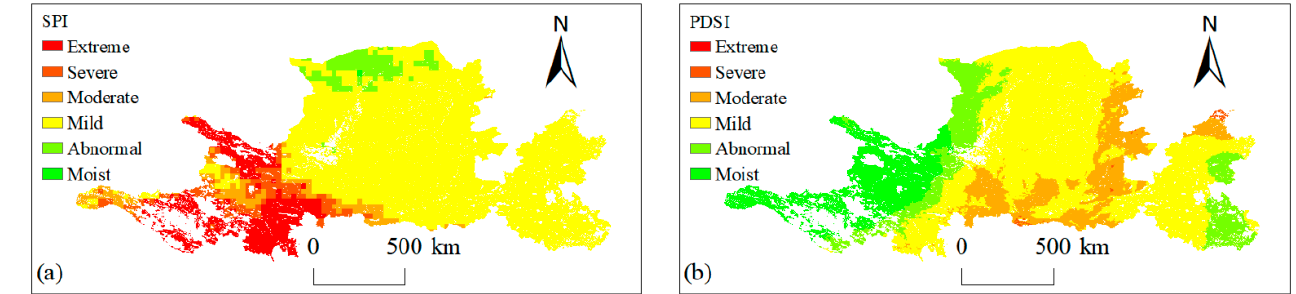
Figure 9. Average of SPI and PDSI with a 1-month time scale during the period 2003–2019. ( a ) SPI; ( b ) PDSI.